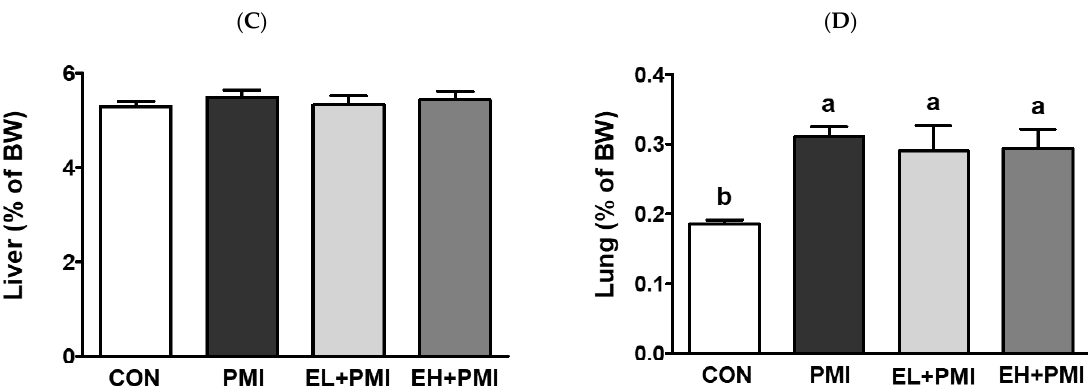
Figure 1. Body and relative weight changes in mice after ellagic acid (EA) pretreatment and particulate matter (PM) instillation. C57BL/6 mice were orally pretreated with ellagic acid (EL; 20 mg/kg or EH; 100 mg/kg) for 7 days, and then PM (5 mg/kg) was intratracheally administrated for 7 days with or without ellagic acid pretreatment: ( A ) body weight, ( B ) delta BW (final minus initial BW), ( C ) liver/body weight ratio, and ( D ) lung/body weight ratio. Values represent the mean ± standard deviation (SD) for each group ( n = 8). Based on the D’Agostino and Pearson omnibus test, one-way ANOVA with Tukey’s post hoc test (for ( A – C )) or Kruskal –Wallis test with Dunn’s post hoc test (for ( D )) was applied. Lowercase letters indicate significant differences. p < 0.05.